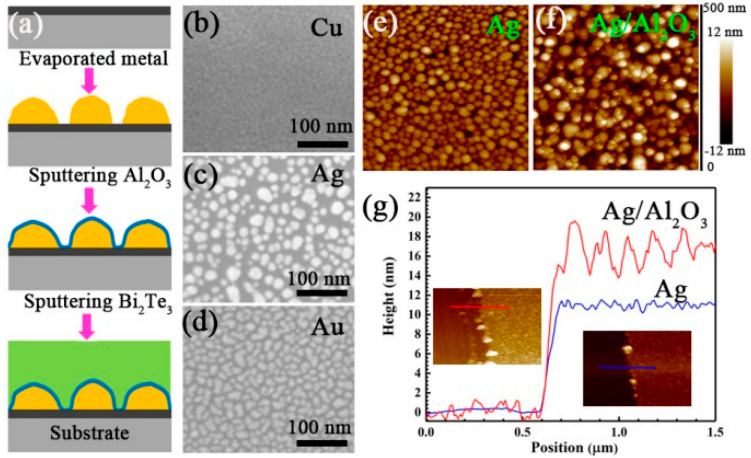
Figure 1. ( a ) Film preparation process. SEM image of ( b ) Cu, ( c ) Ag and ( d ) Au surface. AFM image of ( e ) Ag and ( f ) Ag/ Al 2 O 3 . ( g ) AFM step profiler of Ag and Ag/Al 2 O 3